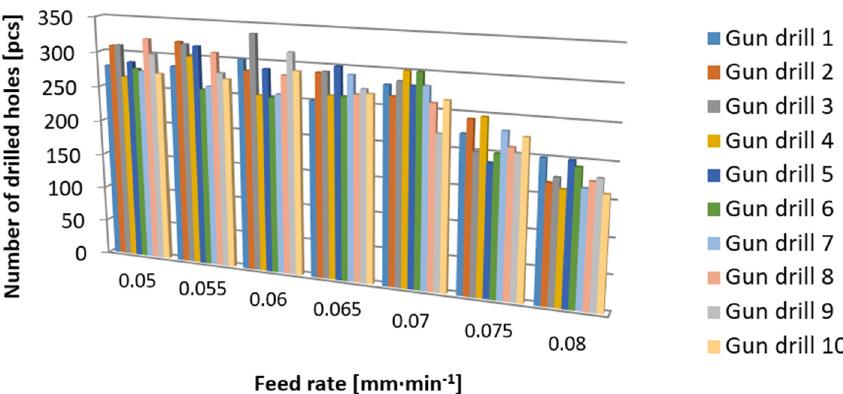
Figure 8. Plotted number of holes drilled until the tool was damaged, when the feed rate changed and the speed remained constant.